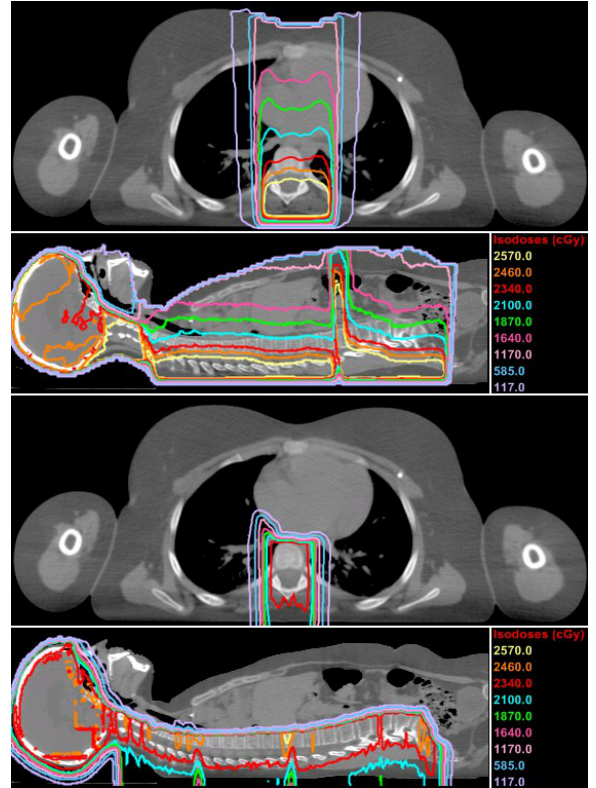
Figure 1. Predicted dose distributions from the primary fields in cGy-RBE for photon CSI at AUBMC (top half) and proton CSI at MD Anderson (bottom half) in axial and sagittal planes. The contour marked in red is the 100% isodose line, representing 23.4 Gy-RBE.